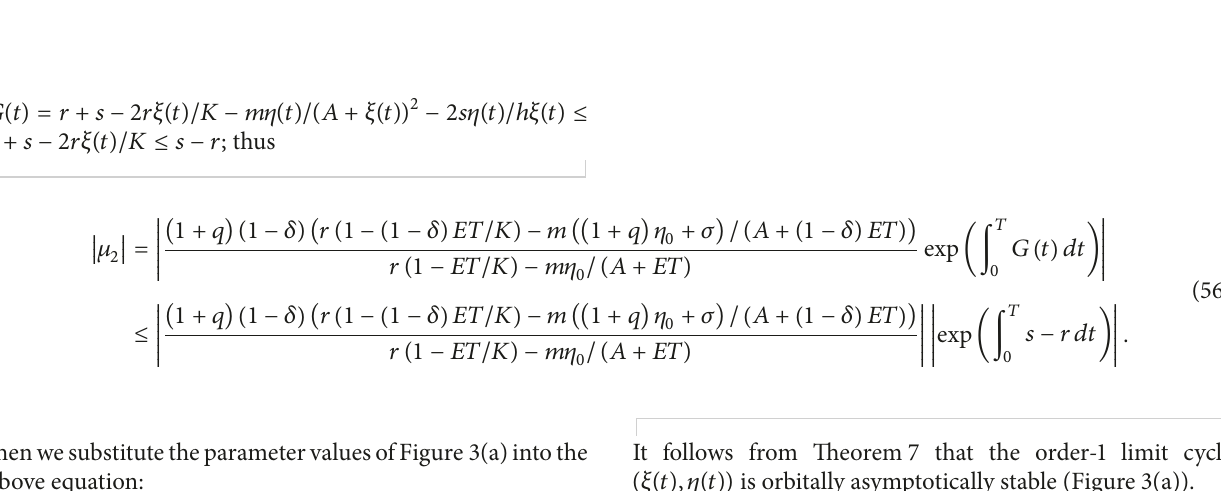
Figure 3: Order-k limit cycles of system (2). (a) Order-1 limit cycle with 𝜎 = 45 ; (b) order-2 limit cycle with 𝜎 = 20 ; (c) order-3 limit cycle with 𝜎 = 13 ; (d) chaos with 𝜎 = 8 . All other parameter values were fixed as 𝑟 = 0.5 , 𝐾 = 50 , 𝑚 = 0.15 , 𝐴 = 0.5 , 𝑠 = 0.043 , ℎ = 1.25 , 𝐸𝑇 = 20 , 𝛿 = 0.3 , and 𝑞 = 0.4